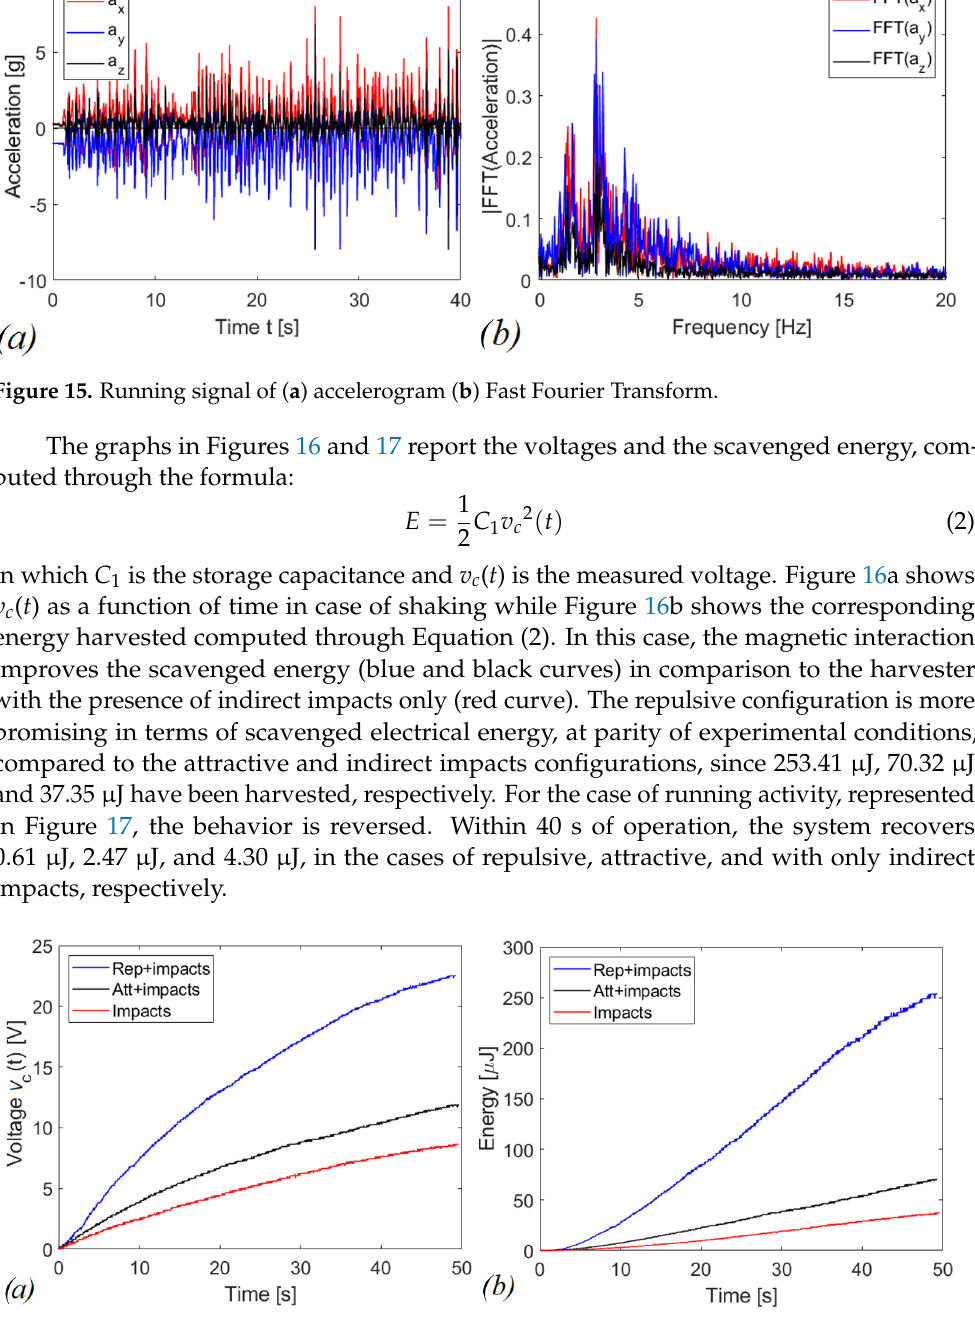
Figure 14. Shaking signal of ( a ) accelerogram ( b ) Fast Fourier Transform.